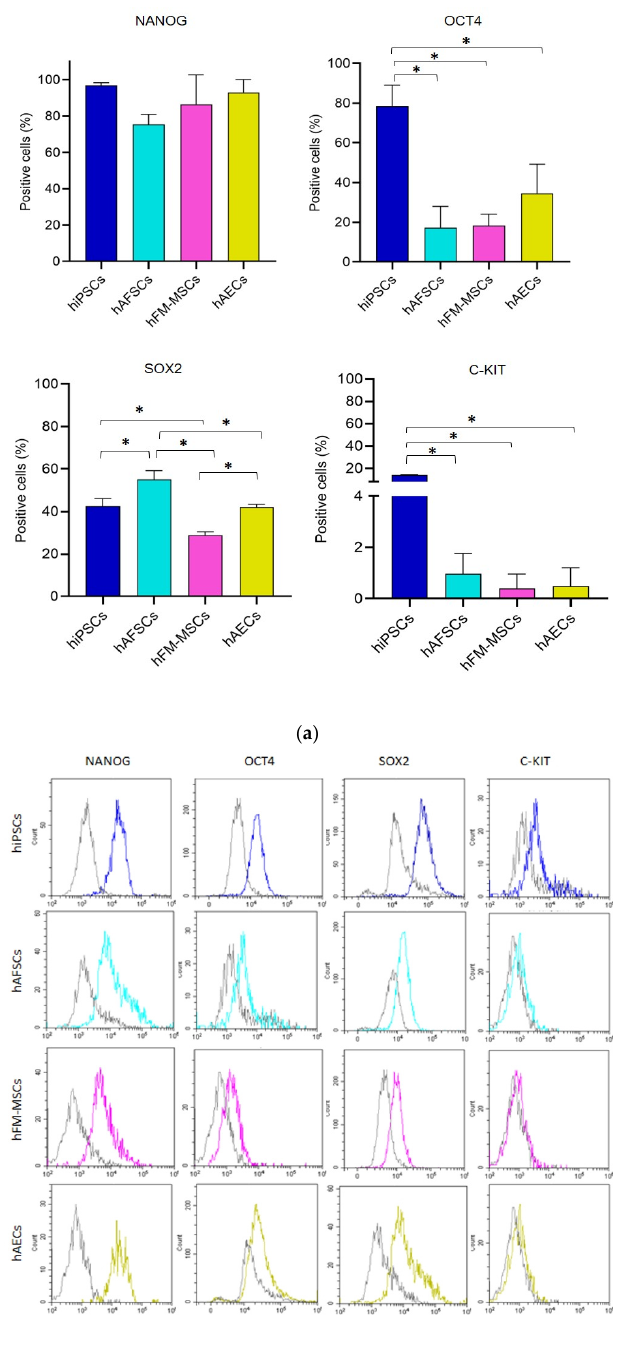
Figure 3. Protein expression of NANOG, OCT4, SOX2, and C-KIT by a flow cytometry analysis in hiPSCs and perinatal SCs. ( a ) Graph bars show the percentage of NANOG, OCT4, SOX2, and C-KIT positive cells in hiPSCs and perinatal SCs, obtained by flow cytometry. The graphs show the mean ± SD of 5 independent experiments, * p < 0.05. ( b ) Representative flow cytometry histograms of NANOG, OCT4, SOX2, and C ‐ KIT in hiPSCs and perinatal SCs, as indicated. Grey histograms represent the isotype controls.